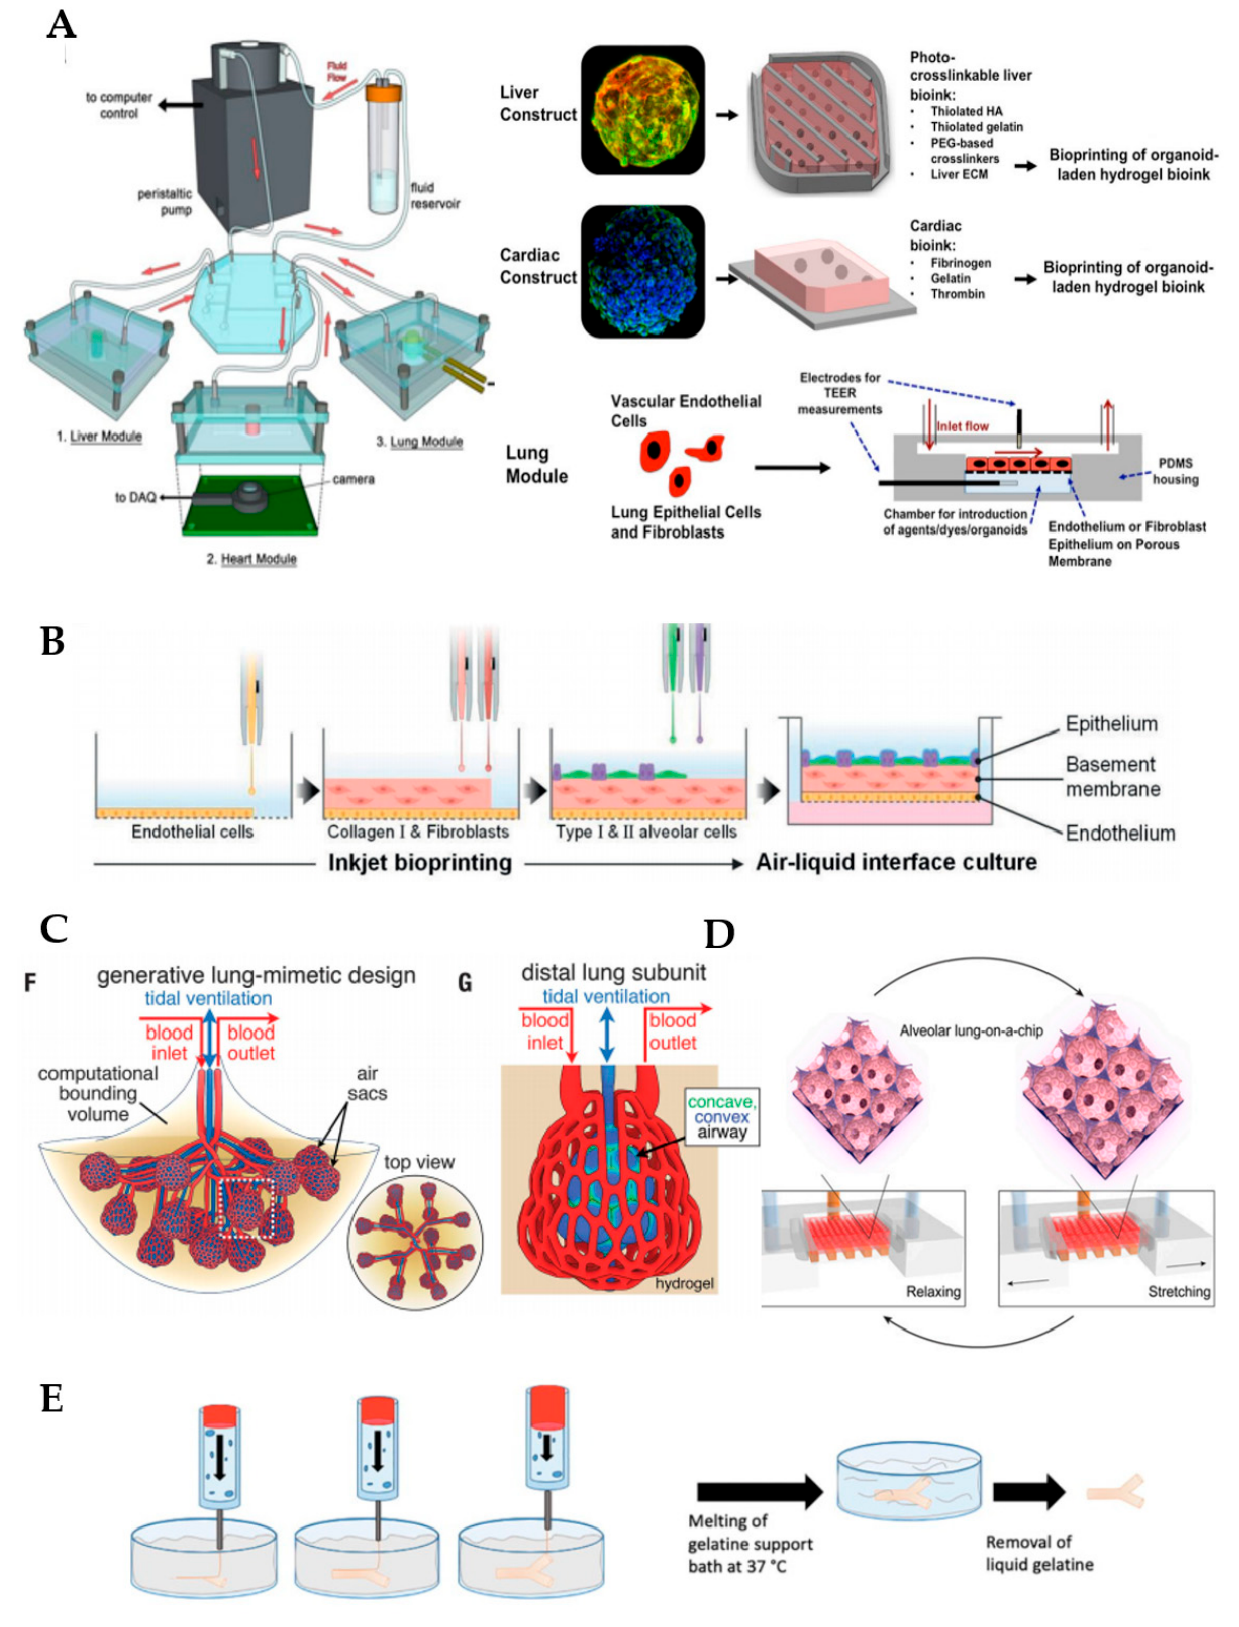
Figure 2. Fabrication of functional lung in vitro models. ( A ) Overall design and implementation strategy for the 3-tissue- representative organ-on-a-chip system using a variety of biofabrication approaches (organoids bioengineering, 3D